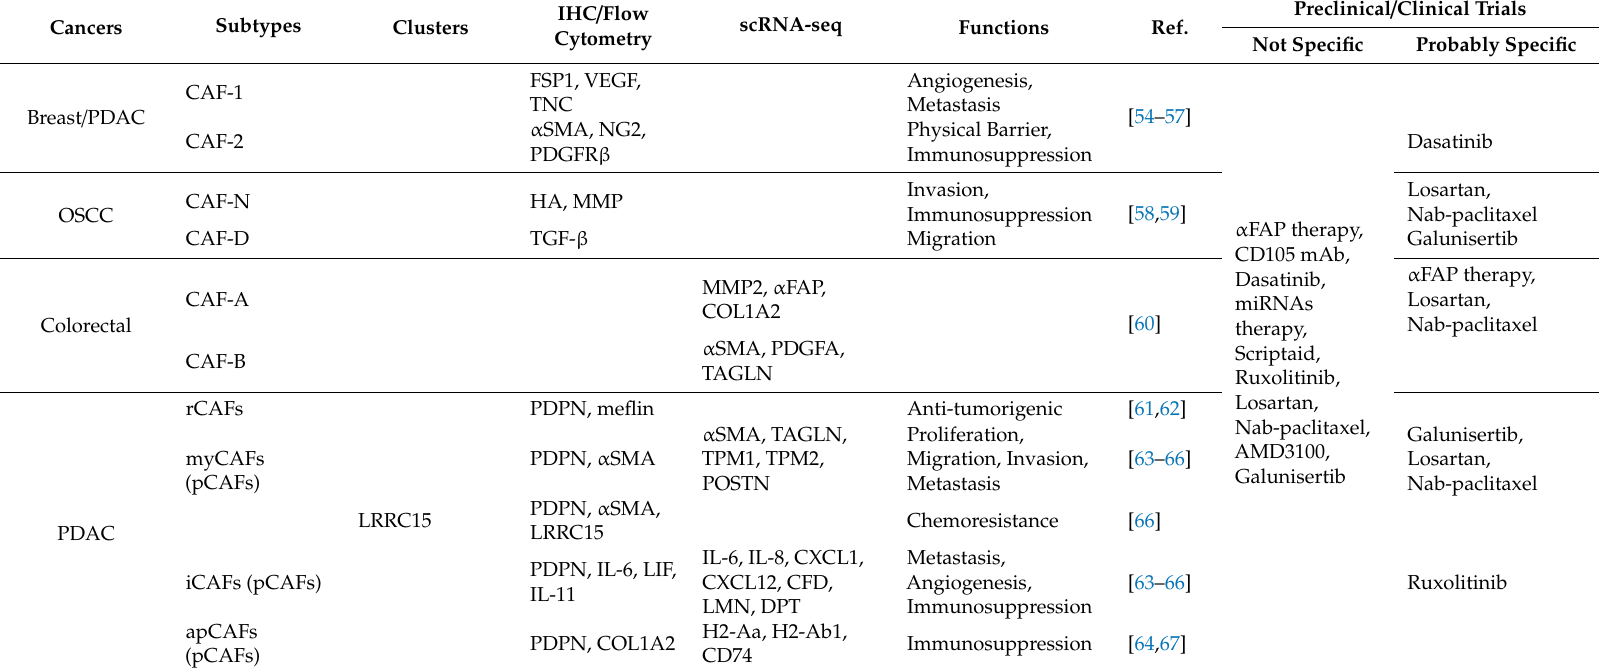
Table 1. Phenotypic and functional heterogeneity of Cancer-Associated Fibroblasts and therapeutic